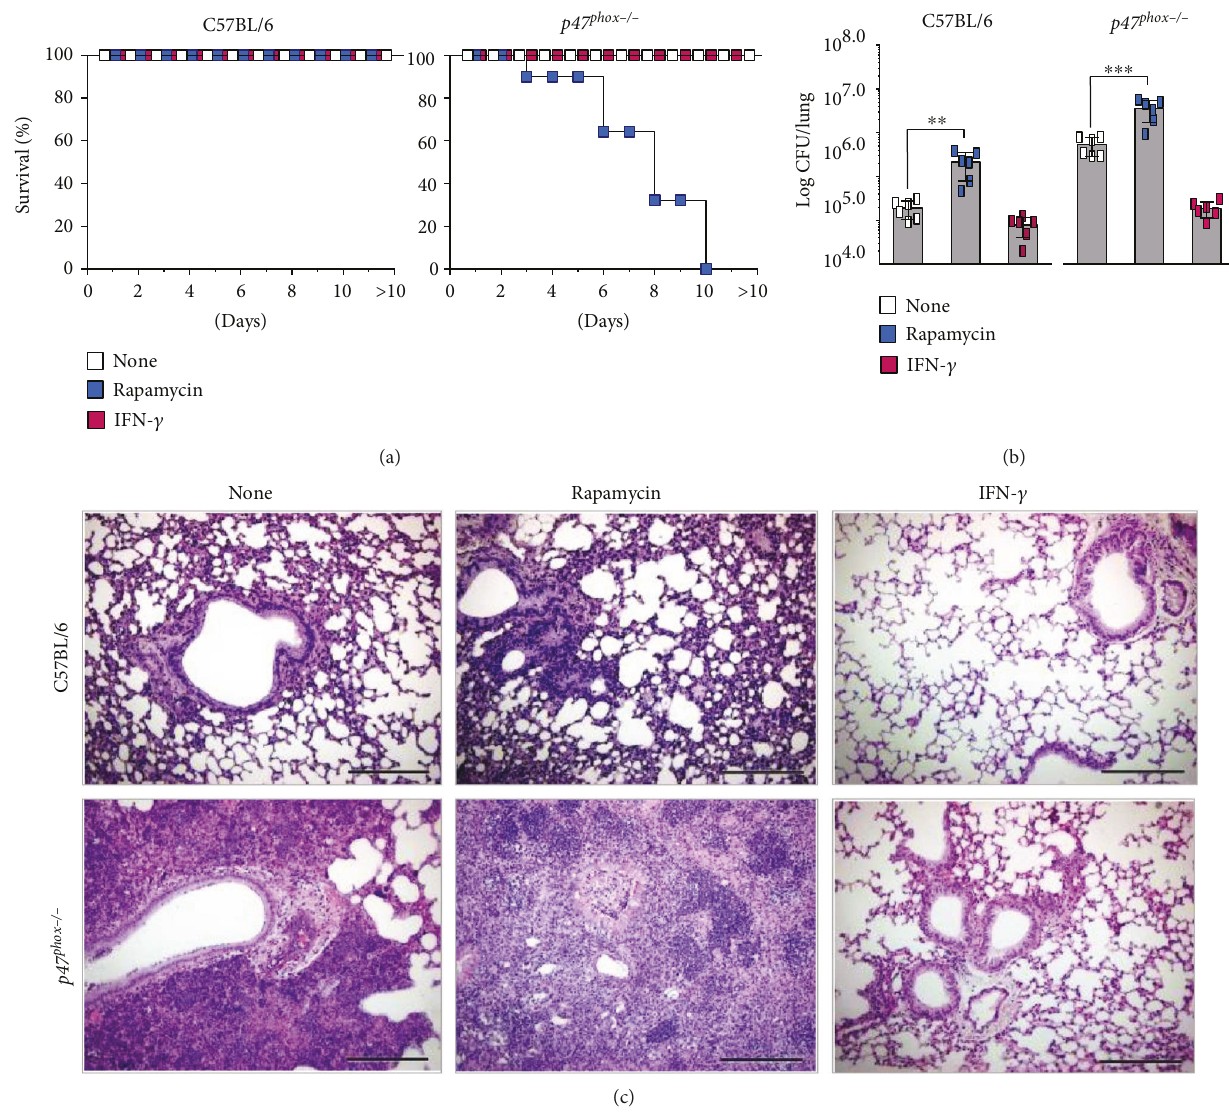
Figure 3: IFN- γ restores defective LAP in p47 phox − / − mice. C57BL/6 and p47 phox − / − mice ( n = 6 ) were infected intranasally with A. fumigatus conidia and treated with rapamycin (10 mg/kg/ip for 3 consecutive days) and IFN- γ (20,000 U/mouse/ip for 7 consecutive days) for one week. Mice were sacri fi ced 7 days after infection and assessed for (a) survival (%), (b) fungal growth (log10 CFU ± SD), and (c) lung histology (PAS staining; scale bar represents 200 μ m). Data are pooled or representative (histology) of three independent experiments. ∗∗ P < 0 001 and ∗∗∗ P < 0 0001 . Treated versus untreated (none) mice. One-way ANOVA, Bonferroni post